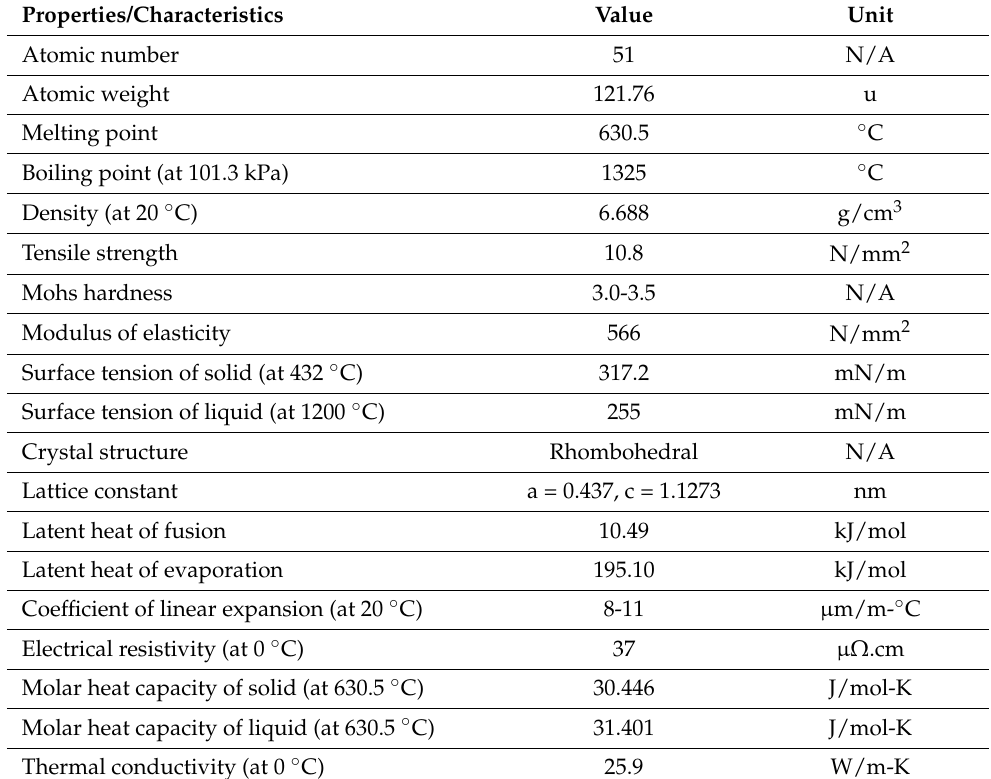
Table 1. Physicochemical and mechanical properties of